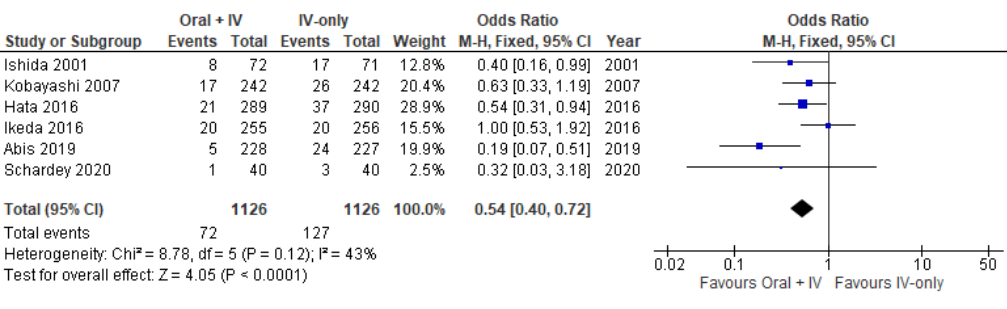
Figure 2. Forest plot of Overall SSIs comparing oral + IV group and IV-only group .